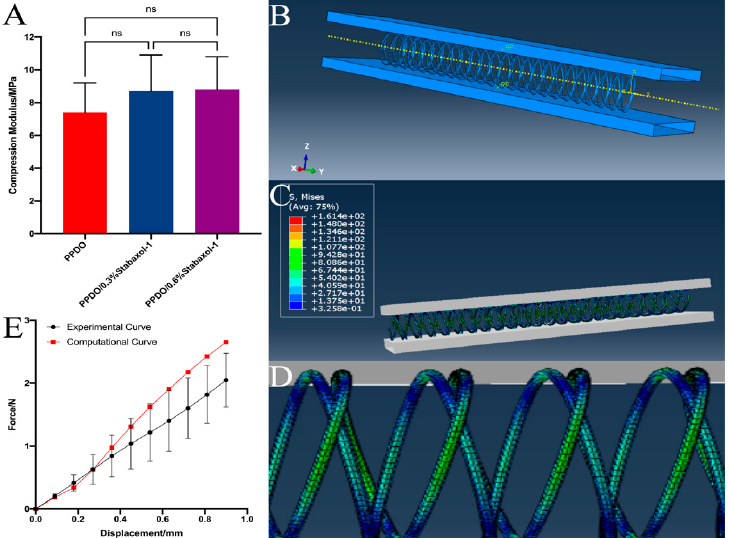
Figure 3. ( A ) Compression forces of PPDO, PPDO/0.3% stabaxol ® -1, and PPDO/0.6% stabaxol ® -1